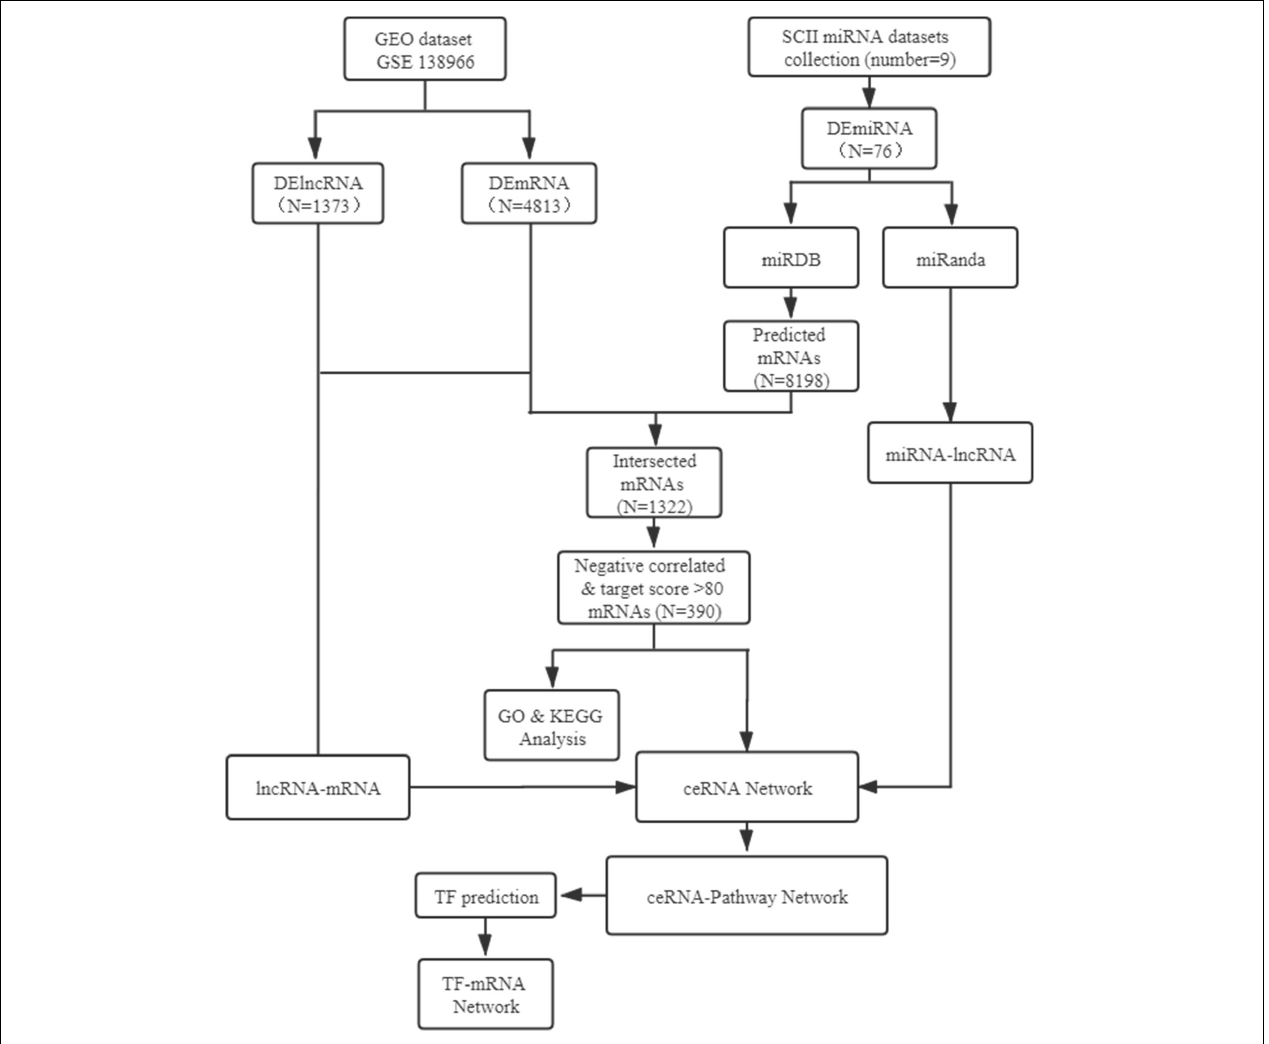
FIGURE 1 | Flow-chat of lncRNA-miRNA-mRNA ceRNA network and TF regulatory network analysis. SCII, spinal cord ischemia/reperfusion injury; DElncRNAs, differentially expressed lncRNAs; DEmiRNAs, differentially expressed miRNAs; DEmRNAs, differentially expressed mRNAs; TF, transcription